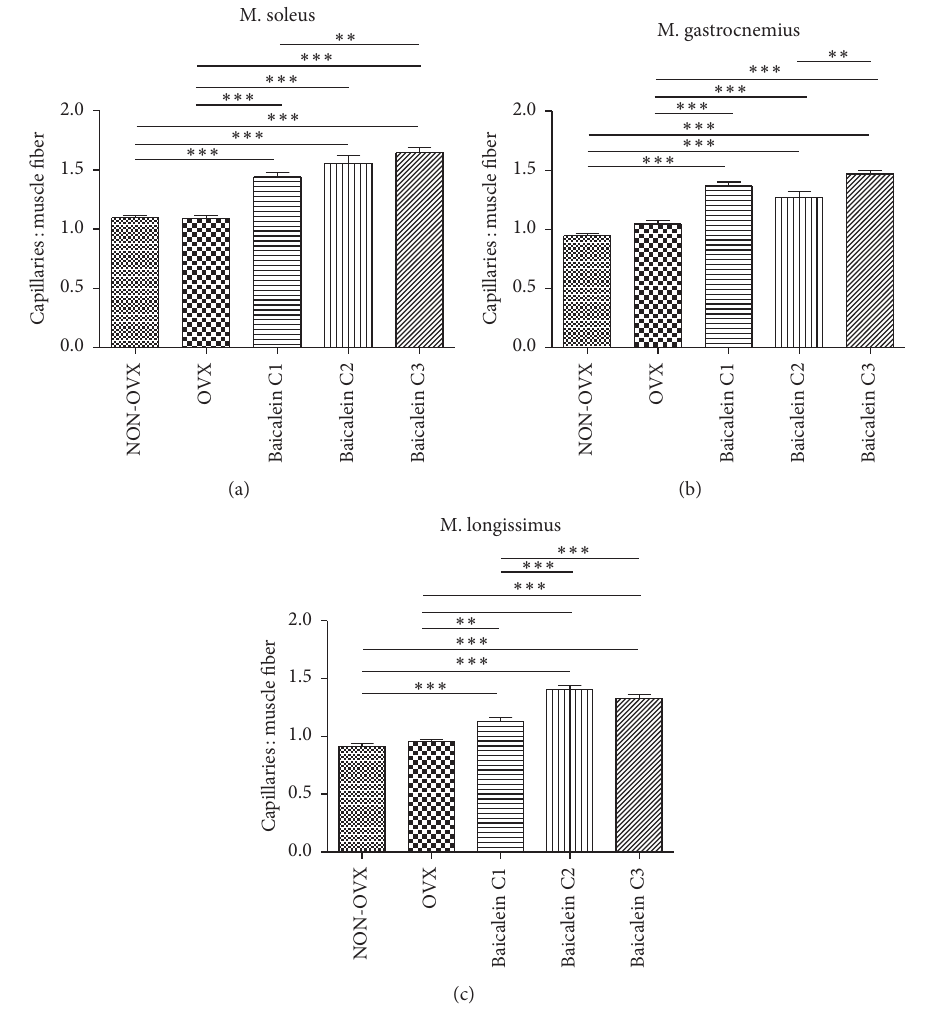
Figure 3: Number of capillaries per single muscle fibre in M. soleus, M. gastrocnemius, and M. longissimus. The numbers of capillaries per muscle fibre in M. soleus ((a), 𝑛 = 92 ), M. gastrocnemius ((b), 𝑛 = 92 ), and M. longissimus ((c), 𝑛 = 91 ) per 0.5 mm 2 were counted; groups treated with baicalein showed a significantly higher number of capillaries per muscle fibre when compared with the untreated groups. The group treated with the highest concentration of baicalein had the most number of capillaries per fibre. ∗∗ 𝑝 < 0.01 and ∗∗∗ 𝑝 < 0.001 indicate significant